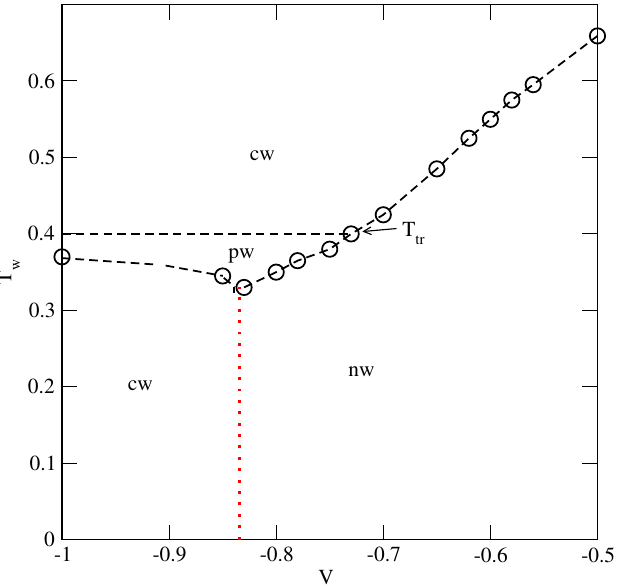
Figure 20. The regions of complete wetting (cw), the partial wetting (pw) and the non-wetting (nw) for the systems with u AB = − 1.0. The horizontal dashed line marks the triple point temperature of the bulk system. The vertical dashed line marks the value of V o , lim , which delimits the non-wetting and complete wetting regions in the ground state. The dotted vertical line marks the expected value of V o , which delimits the non-wetting and complete wetting regions at T = 0 in the isotropic systems with ¯ u = − 0.75.